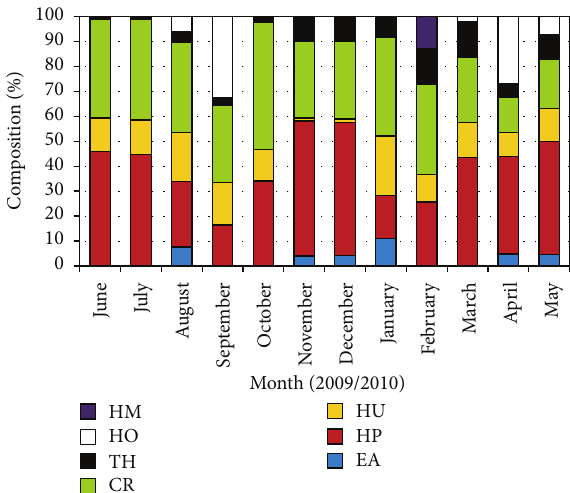
Figure 2: Monthly changes of mean seagrass species composition June 2009 to May 2010 (HM: Halophila minor , HO: Halophila ovalis , TH: Thalassia hemprichii , CR: Cymodocea rotundata , HU: Halodule uninervis , HP: Halodule pinifolia , and EA: Enhalus acoroides ).